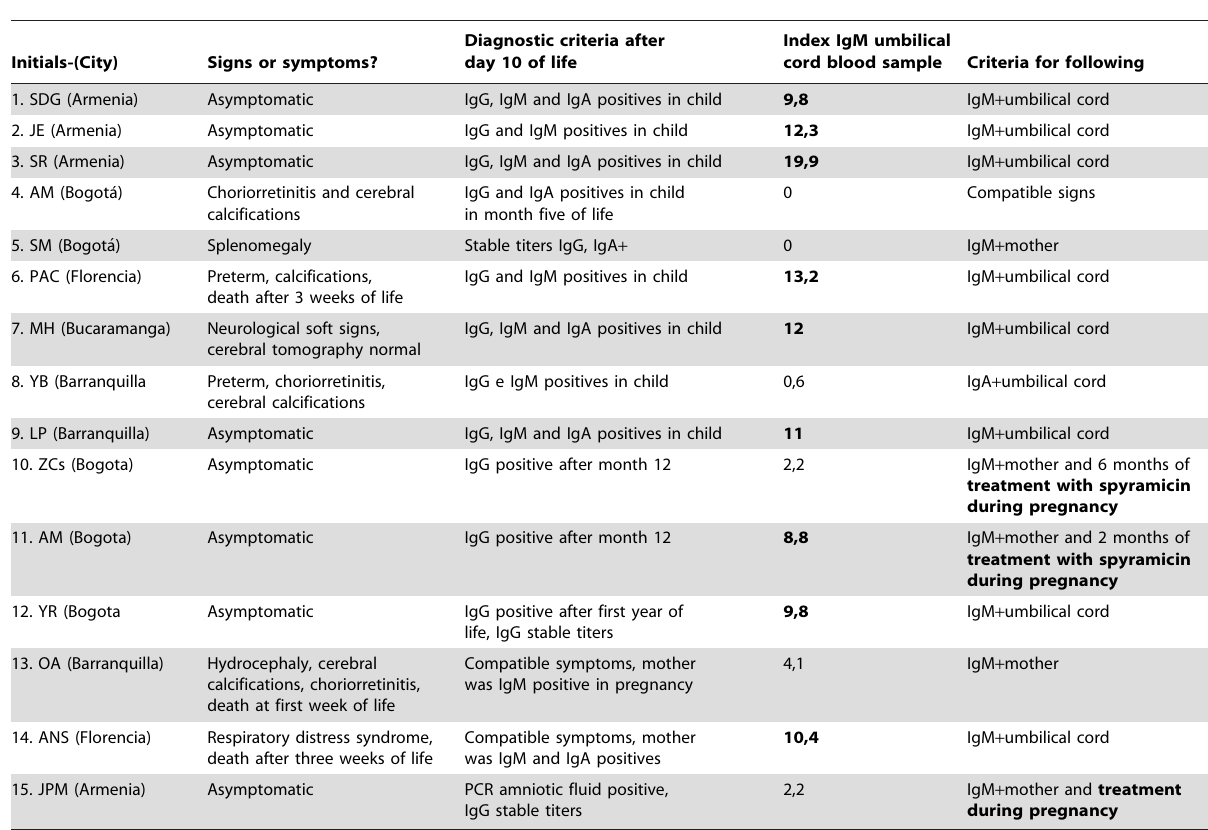
Table 3. Clinical and serological characteristics in 15 children with confirmed congenital Toxoplasma infection.